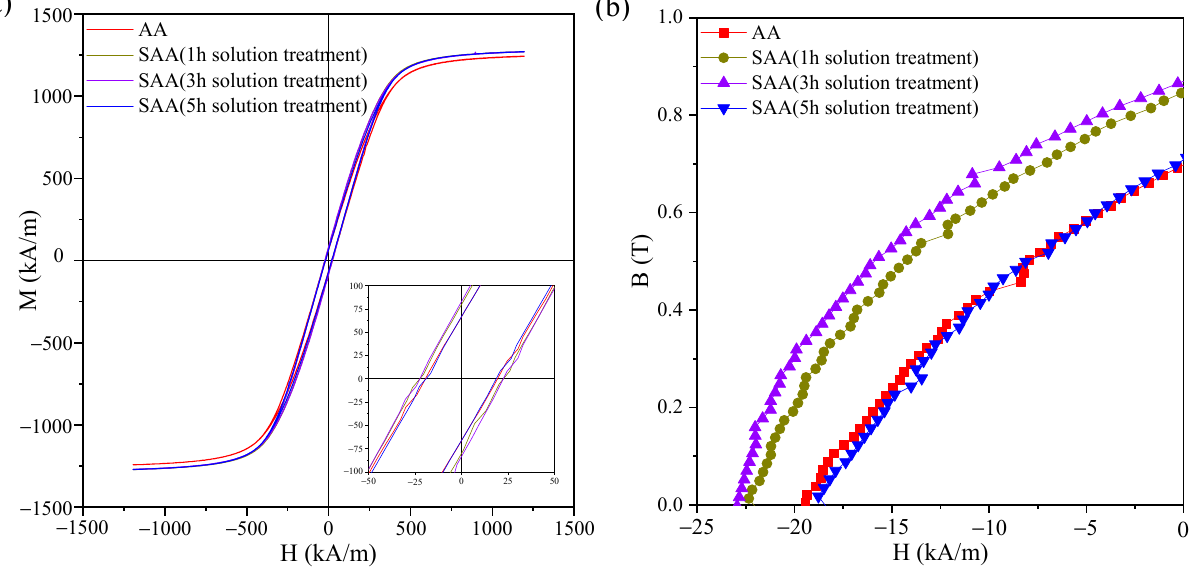
Figure 8. ( a ) Magnetic hysteresis loops (M-H) and ( b ) demagnetization curves (B-H) of Fe-25Cr-15Co alloys under different thermal treatments. Table 2. The magnetic properties of Fe-25Cr-15Co alloys under different thermal treatments.